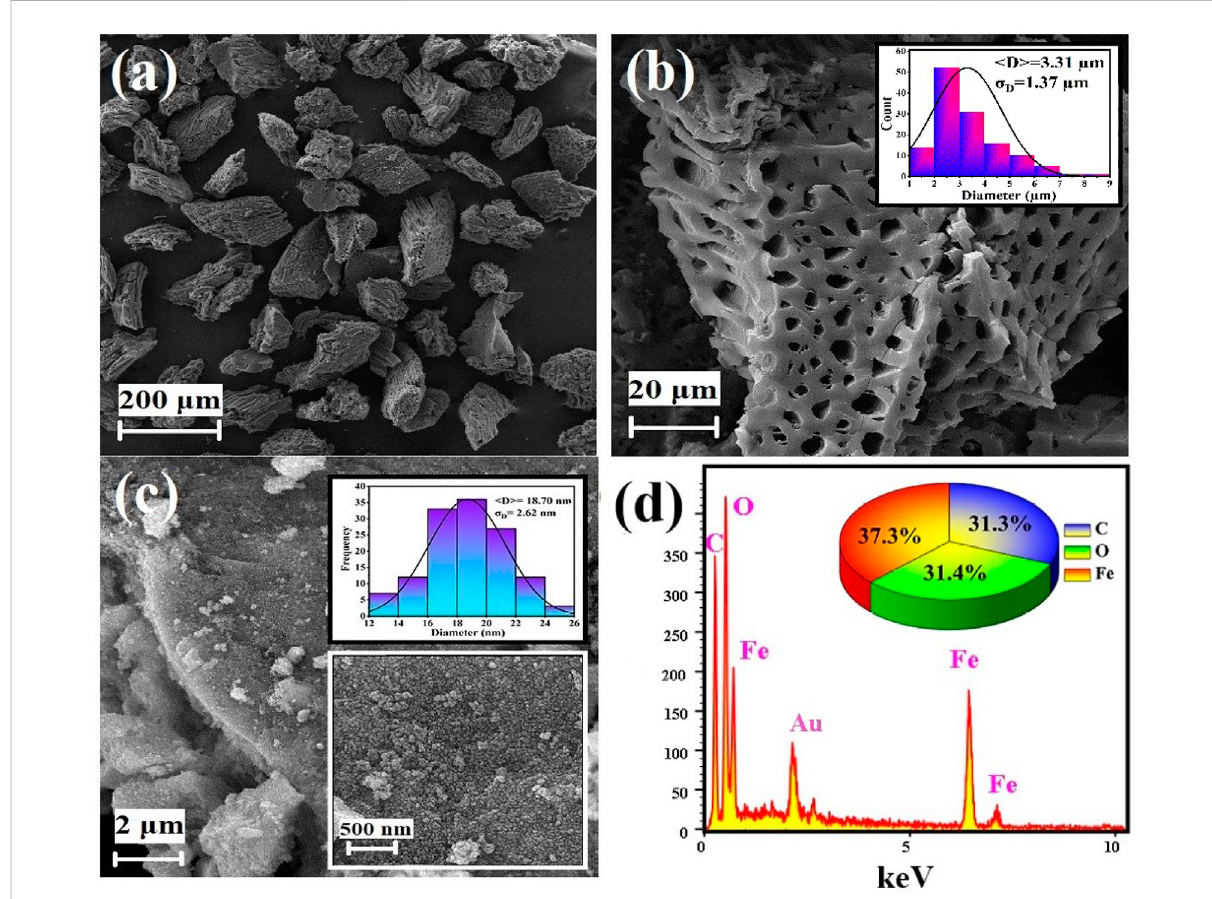
FIGURE 4 (A) and (B) FESEMimagesofOlestearseedsdrivedactivatedcarbon(AC),and (C) FESEMimageofFe 3 O 4 /ACnanocomposite. (D) EDXspectraof